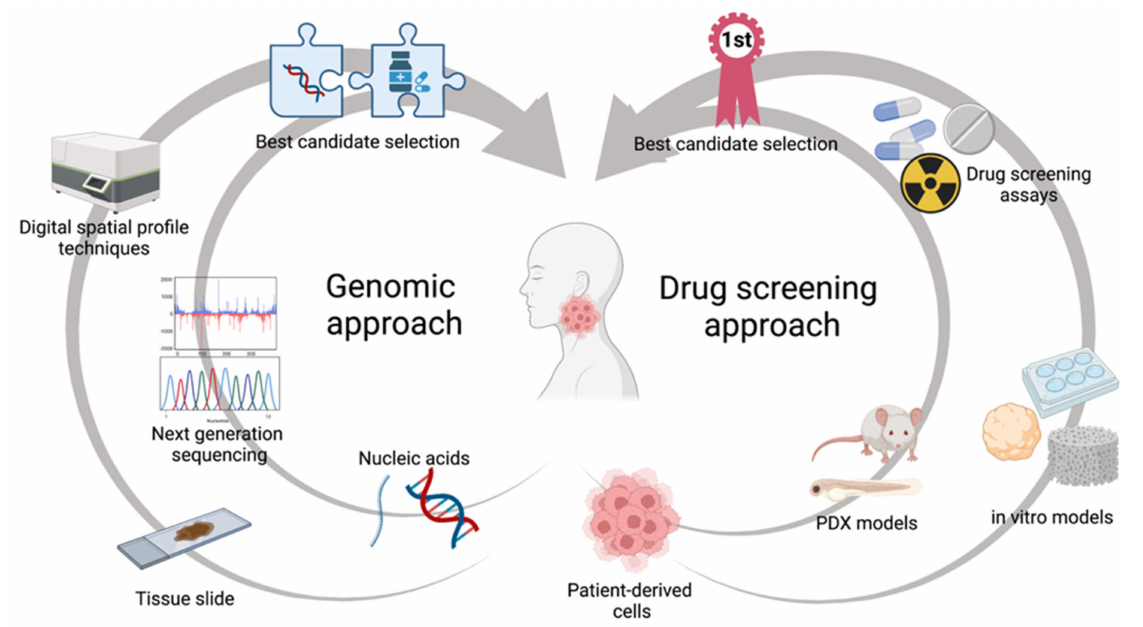
Figure 1. The two main precision medicine options in HNC oncology: genomic and drug screening approaches. Image created with